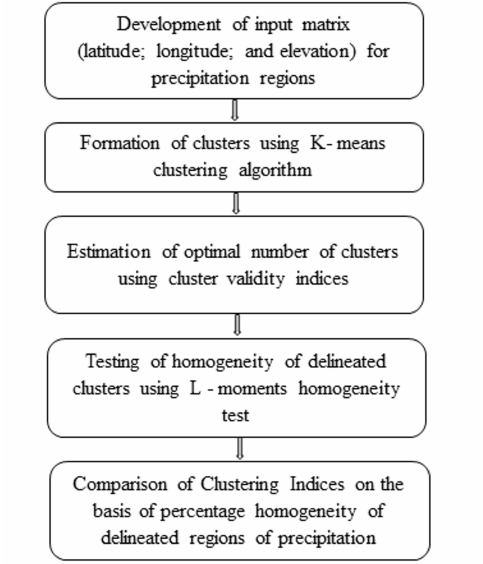
Figure 1. Framework for the delineation of precipitation